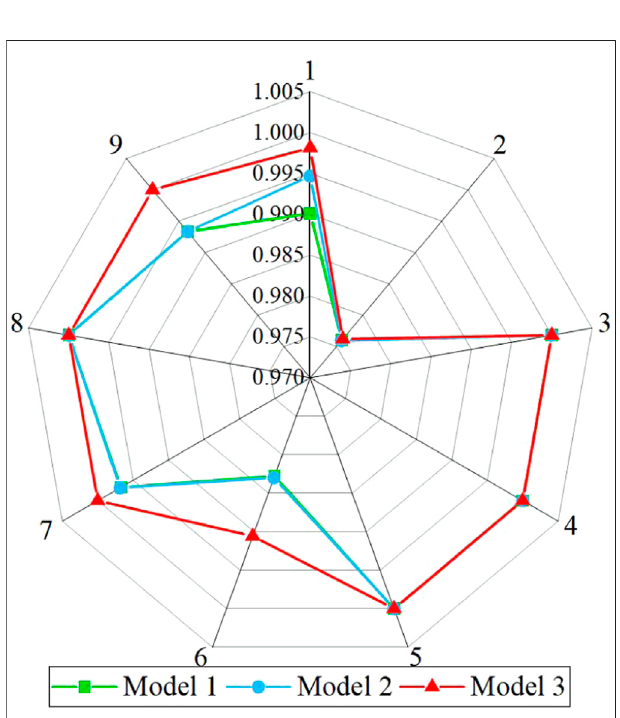
FIGURE 10 | Node voltage distribution at typical